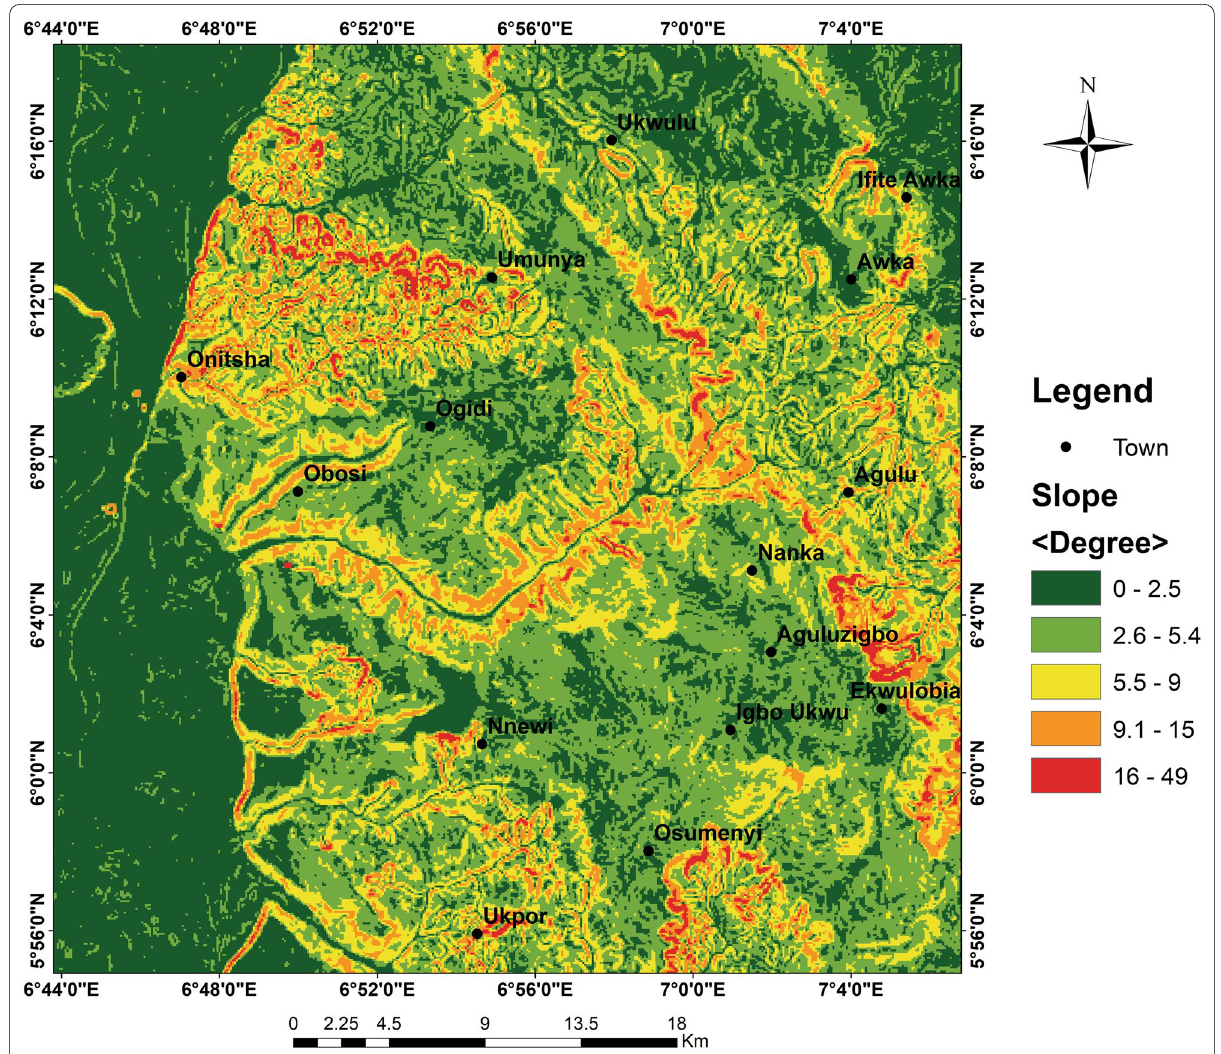
Fig. 4 Slope map (Ml) of the study, area where Nanka formation outcropped. Generated from NASA SRTM-30m